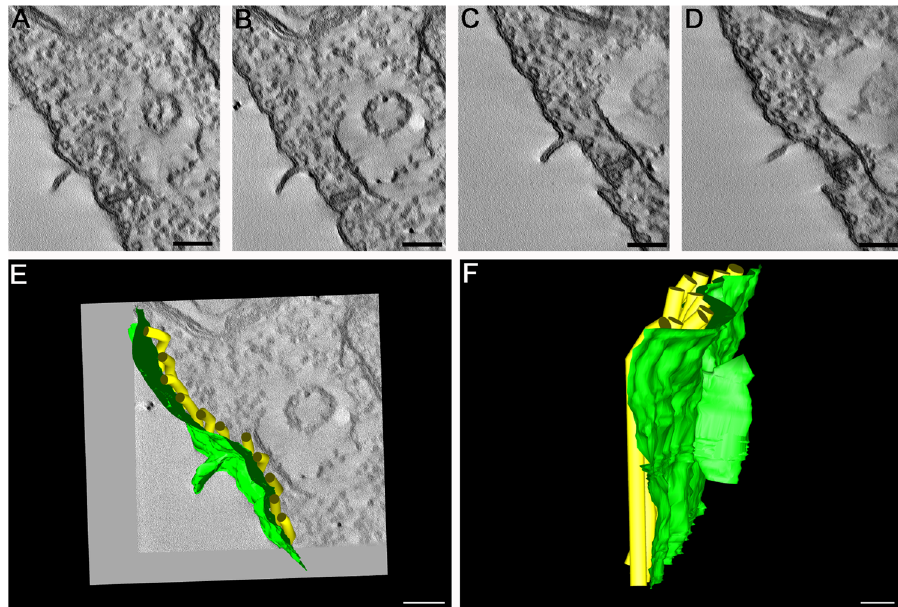
Figure 12. Electron microscopy tomography and 3D reconstruction showing a projection of the plasma membrane of L. amazonensis promastigotes treated with 5 µM SBC 39 for 6 h. The images confirmed the presence of the endoplasmic reticulum profile near the projection and the absence of microtubules associated with it.